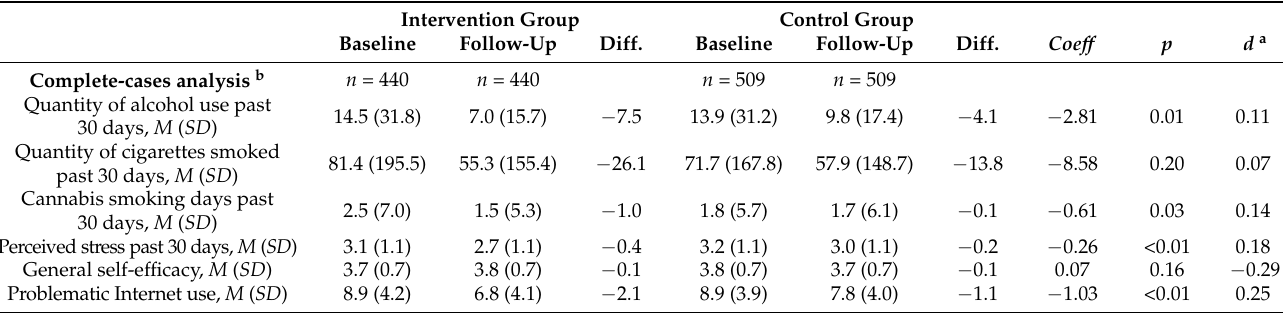
Table 3. Intervention effects for continuous outcomes.